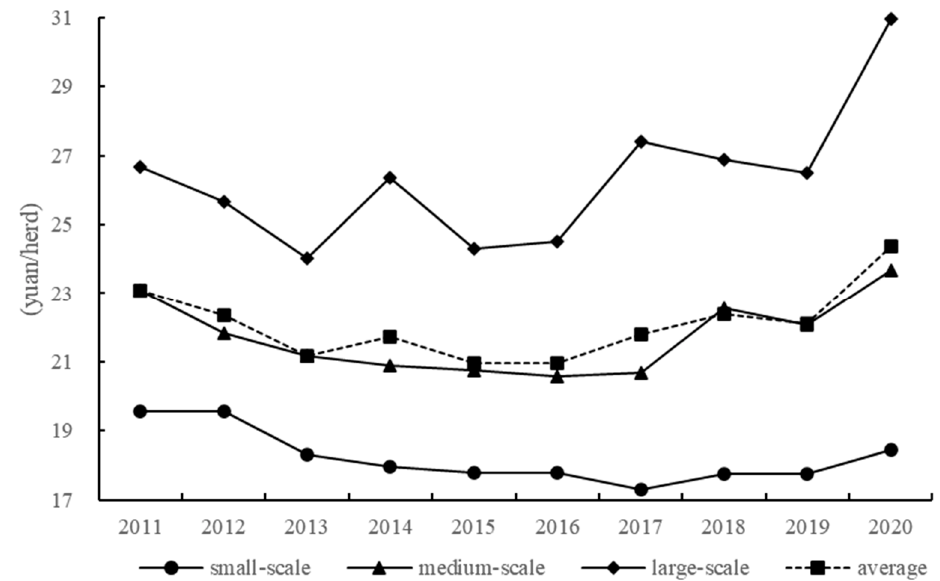
Figure 5. Annual other costs of hog production of different scales in China from 2011 to 2020.